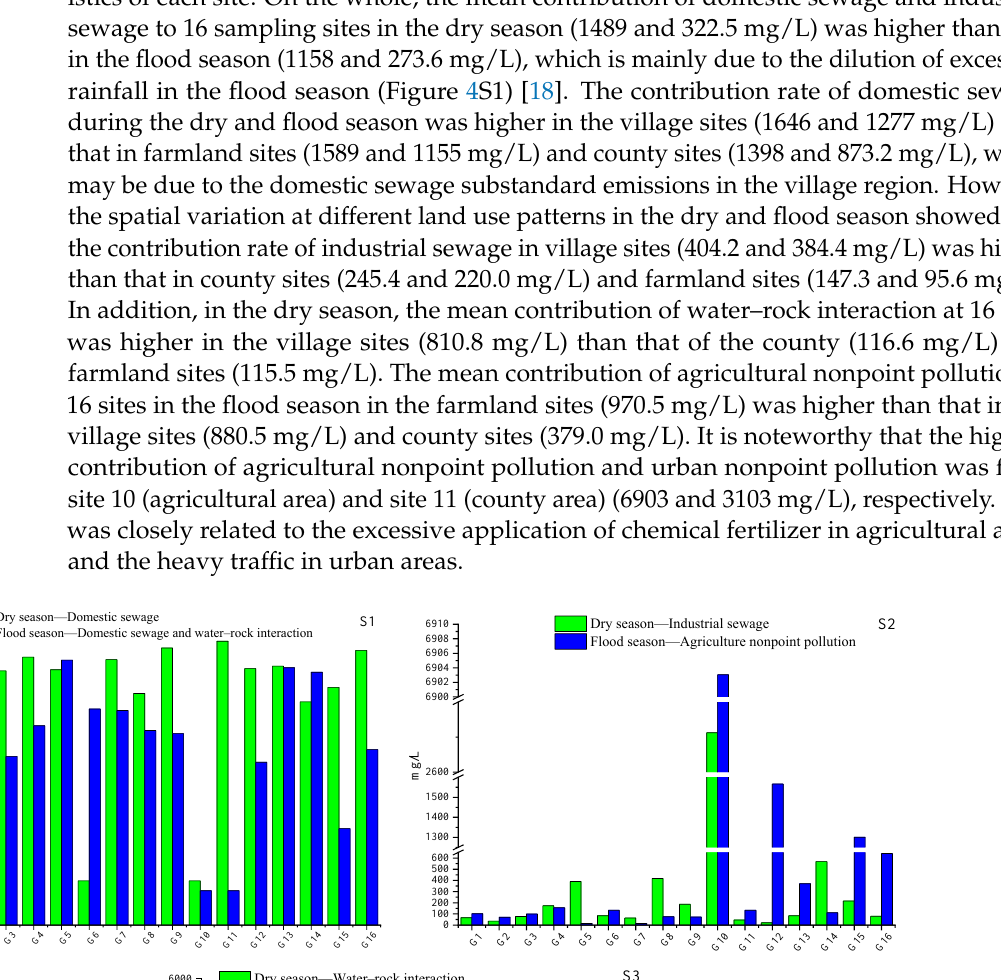
Figure 4. Estimated contributions (mg/L) from each source at the sampling sites during the dry and flood seasons obtained by the PMF model (Note: ( S1 ): Source 1; ( S2 ): Source 2; ( S3 ): Source 3). 3.6.2. Estimated Contribution Rate (%) of Each Source to 14 Water Quality Variables The contribution proportion of each source to each groundwater quality parameters was calculated using the PMF model. As shown in Figure 5, in the dry season, most of the water-quality parameters were affected by domestic sewage (76.3% of TDS, 63.5% of K + , 74.7% of Na + , 75.3% of Ca 2+ , 76.9% of Mg 2+ , 73.3% of Cl − , 59.7% of SO 42 − , 63.1% of NO 3 − , 58.0% of COD and 75.9% of TH) industrial sewage (73.0% of Fe, 58.2% of Mn, 32.3% of COD and 28.4% of SO 42 − ) and water–rock interaction (78.4% of pH and 73.4% of HCO 3 − and 31.5% of